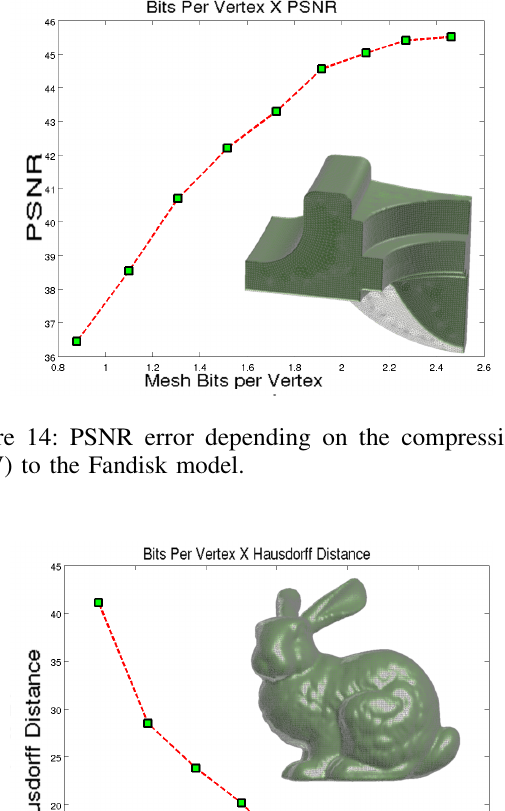
provide better minimization results